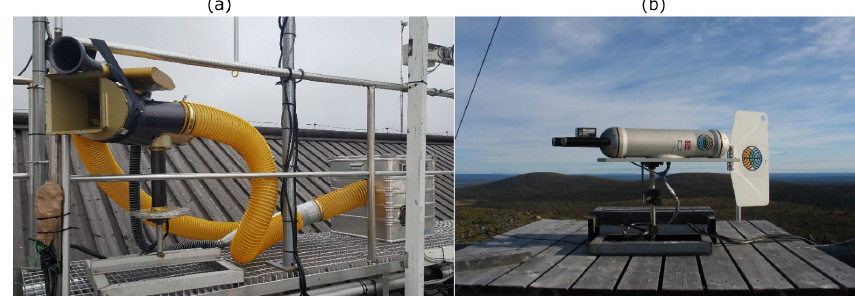
Figure 3. CAPS (a) and FSSP-100 (b) ground setups as installed on the roof of Sammaltunturi